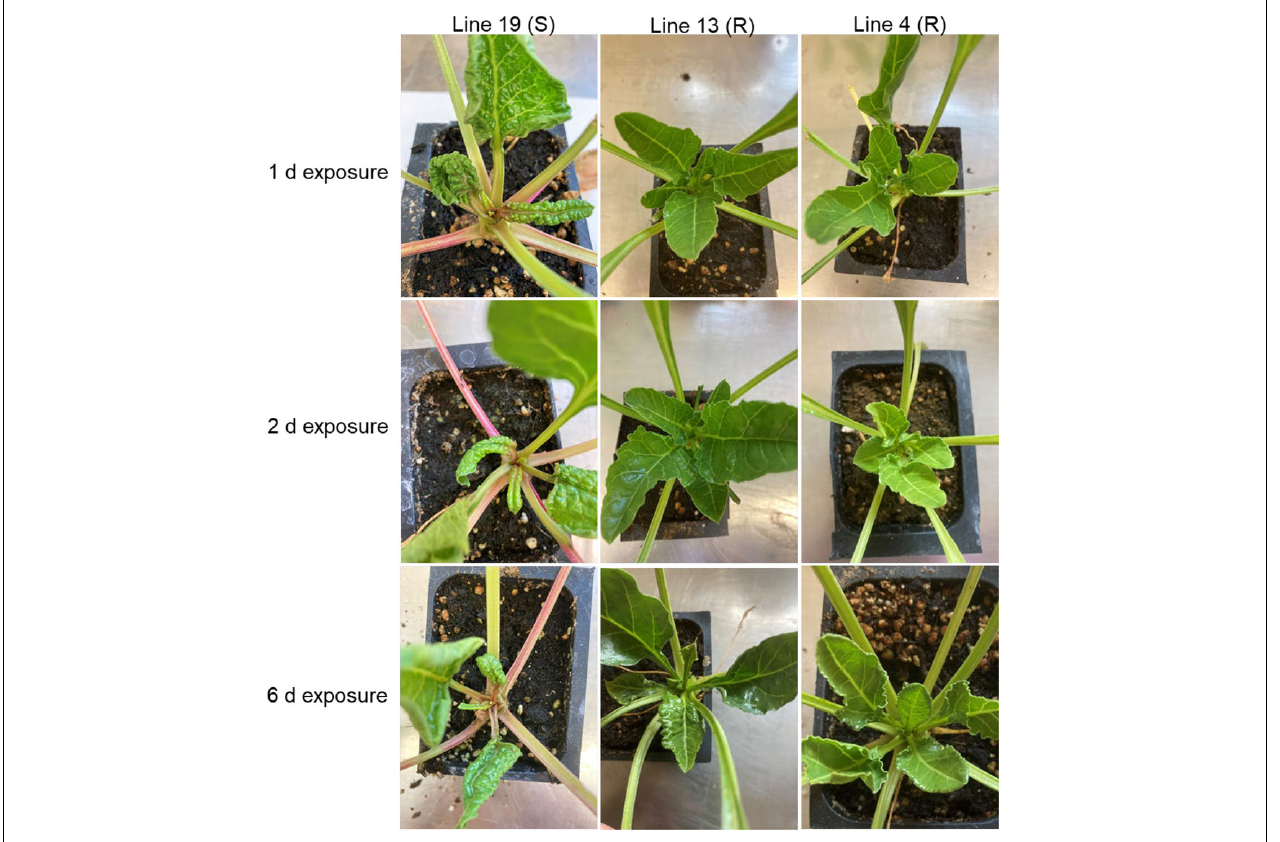
FIGURE 7 | Disease symptoms in sugar beet plants that were earlier infected by BCTV. Beet curly top virus symptoms in the apical leaves at 3 weeks post BCTV inoculation in the susceptible (Line 19; S) and resistant (Line 13 and Line 4; R) sugar beet lines that were exposed to viruliferous beet leaf hoppers for 1 d, 2 d, and 6 d